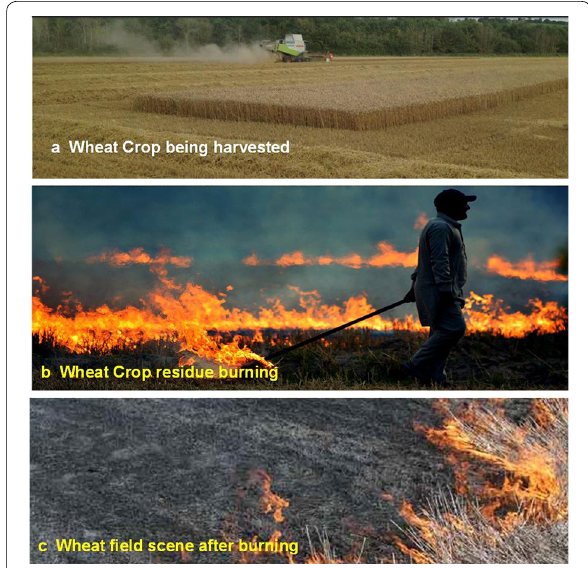
Fig. 1 a Wheat crop being harvested. b Wheat crop residue burning. c Wheat field scene after